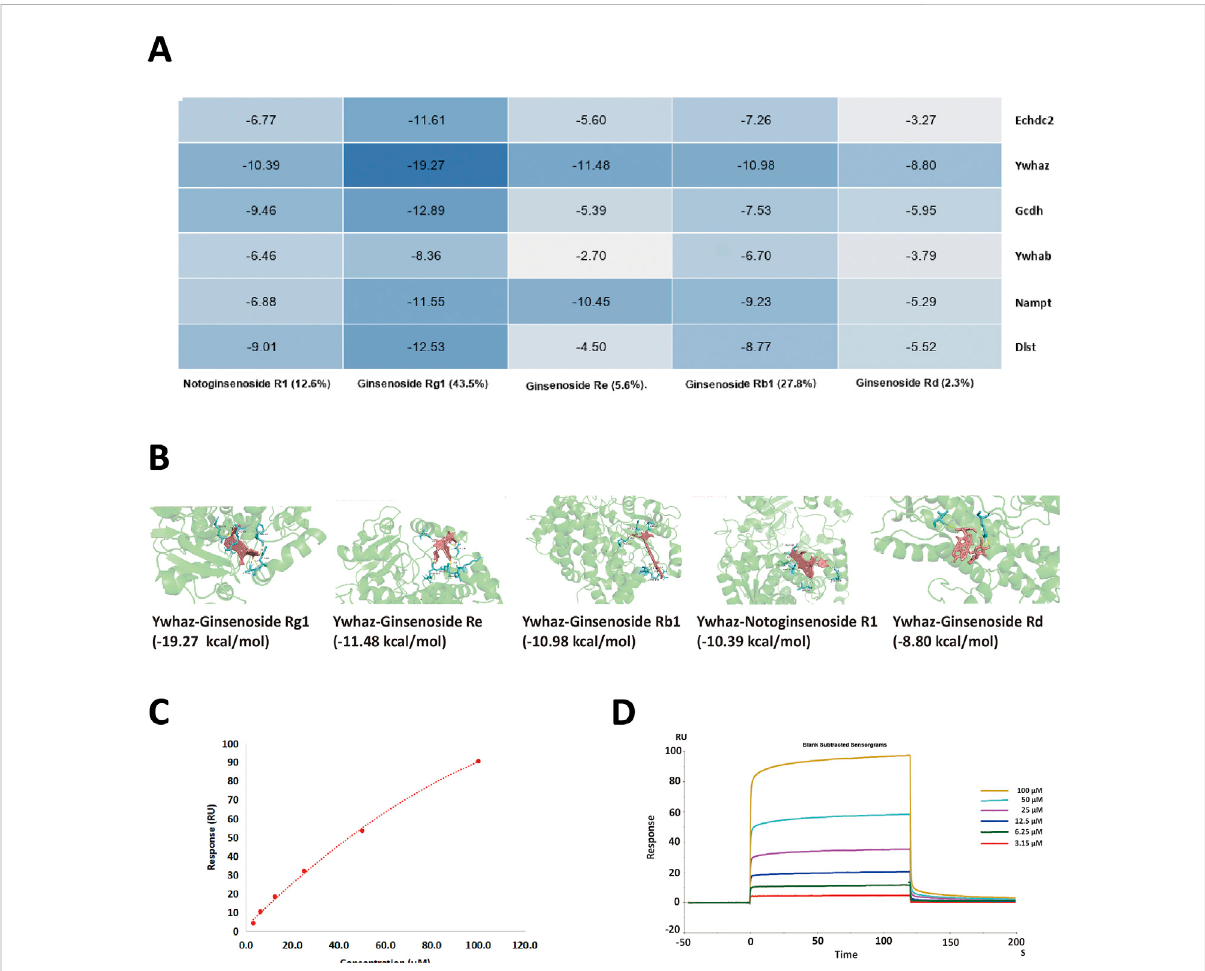
FIGURE 8 (A) Heatmap of binding energy between the fi ve small molecule ligands and six DEPs, respectively. The darker the blue color, the lower the binding energy (kcal/mol) and the better the interaction are. (B) 3D structure of Ywhaz interactions. The key residues that contact the chemical compound are labeled in cyan. The chemical compound is shown in pink. (C,D) SPR assay analysis of the binding between Ywhaz and ginsenoside Rb1 at different concentrations. The open bar in (D) indicates the duration of ginsenoside Rb1 perfusion in SPR.